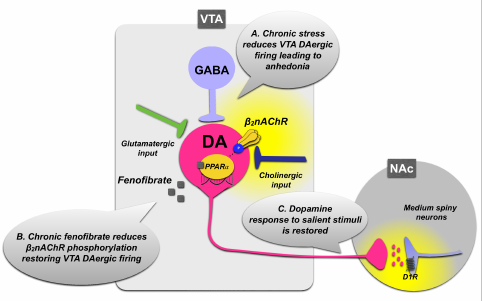
Figure 2. Schematic representation of PPAR α regulation of dopamine neuron activity in the ventral tegmental area (VTA). ( A ) Unavoidable stress exposure is associated with decreased burst firing of dopamine neurons in the VTA and impaired dopaminergic response in the NAc. ( B ) Long- term PPAR α activation by agonist administration (fenofibrate) decreases phosphorylation levels of β 2-subunit-containing nicotinic acetylcholine receptor ( β 2nAChR) in the VTA, thus counteracting the negative modulatory effect on dopaminergic transmission of phosphorylated β 2nAChRs. The decreased phosphorylation levels of β 2nAChRs lead to increases in burst firing of VTA dopamine neurons ( C ), an effect that is accompanied by increased dopaminergic responses to salient stimuli in the nucleus accumbens (NAc). PPAR α activation by relieving the inhibition of VTA dopamine neurons may restore the NAc physiological response to salient